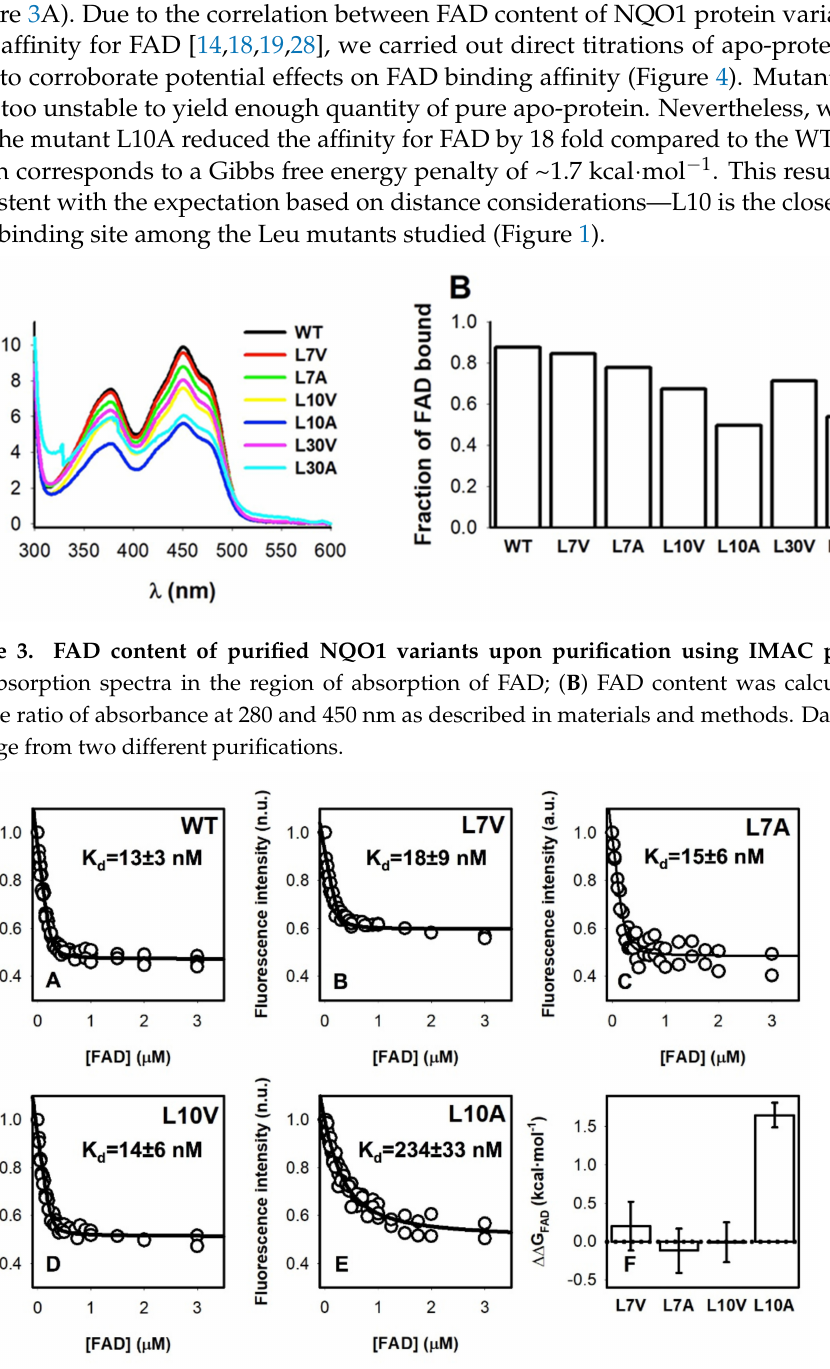
Figure 4. Fluorescence titrations of NQO1 apo variants with FAD. ( A – E ) Experimental data are shown as circles and lines are best fits to a single type of independent binding sites. Data are from at least two independent experiments (N = 4 for WT and N = 2–3 for the mutants). ( F ) The changes in apparent binding free energy including errors from linear propagation. Experiments were performed at 25 ◦